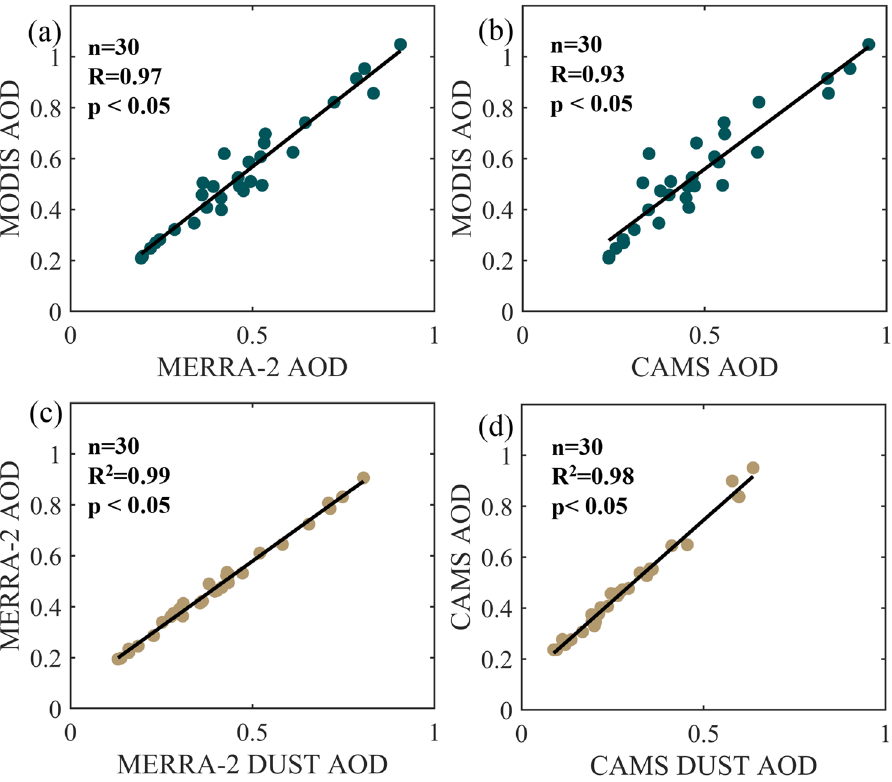
Figure 3. Correlations in AOD between ( a ) MODIS and MERRA-2, ( b ) MODIS and CAMS, ( c ) percentage variation in MERRA-2 AOD due to dust AOD ( d ) percentage variation in CAMS AOD due to dust. The datasets are used from 1st to 30th June 2020. The map was generated using MATLAB 2015b, www. mathw orks.